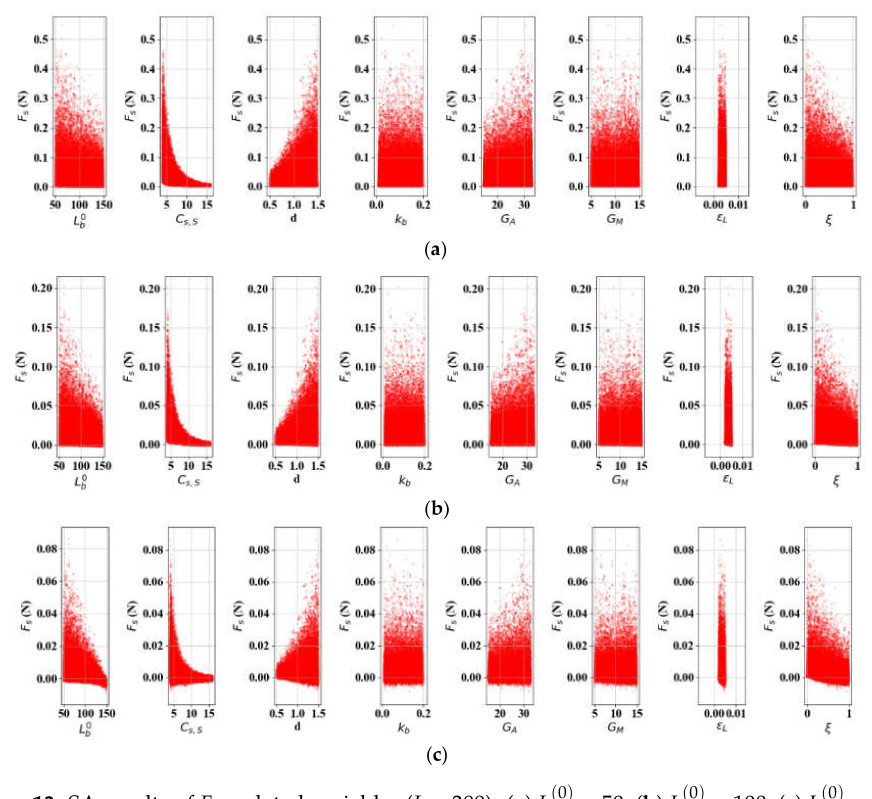
Figure 13. SA results of F S - related variables ( L = 300): ( a ) L Table 5. Total Sobol indices ( ST ) of F S ( L ( 0 ) b